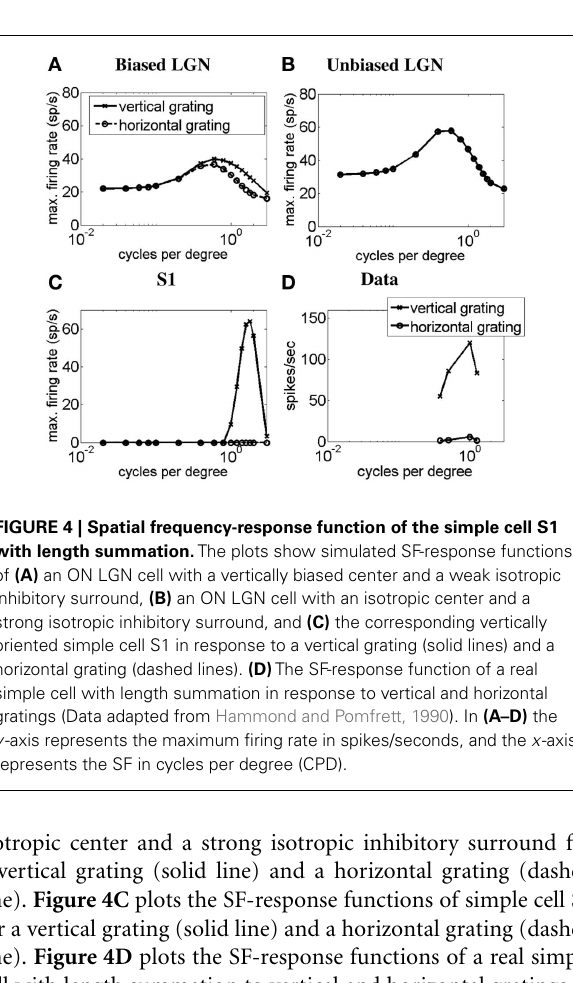
with end-stopping in response to a bar of optimum orientation.